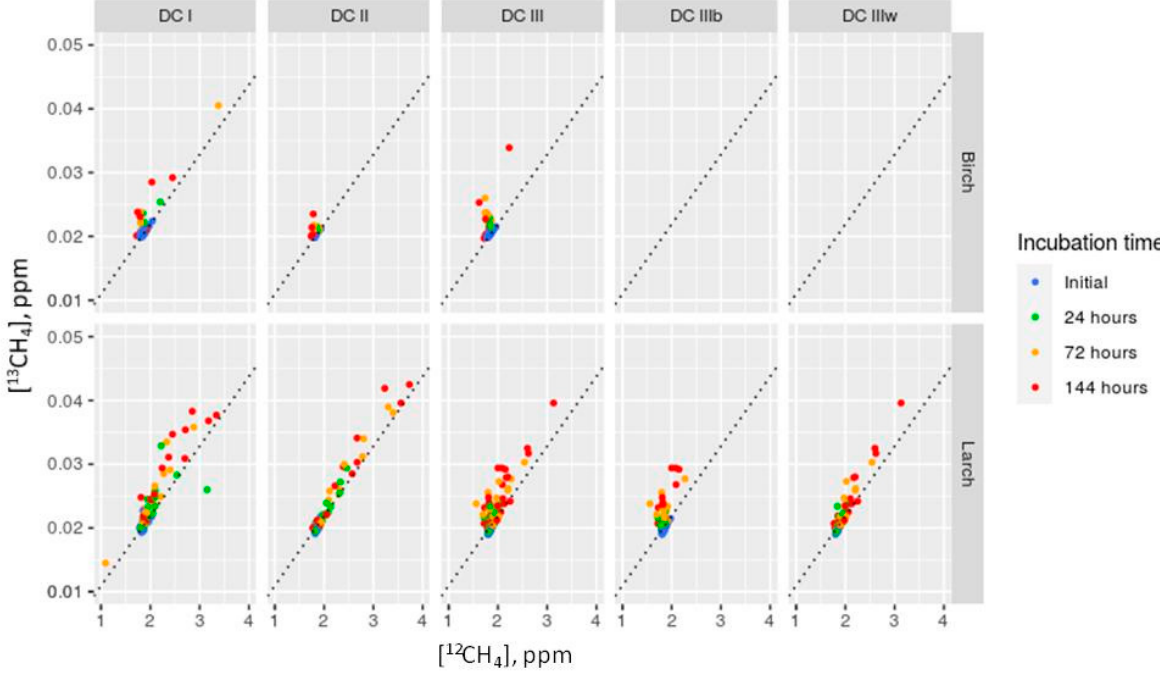
Figure 3. The relationship between 12 CH 4 ([ 12 CH 4 ], ppm) and 13 CH 4 ([ 13 CH 4 ], ppm) content during incubation of larch and birch CWD: DC I–DC III—decomposition Classes; DC IIIb—CWD of Decomposition Class III decomposed by brown rot fungi; DC IIIw—CWD of Decomposition Class III decomposed by white rot fungi. Dotted line indicates reference ratio between 13 CH 4 and 12 CH 4 if to assume that δ 13 C in the produced methane is similar to that in the substrate (decomposing wood).